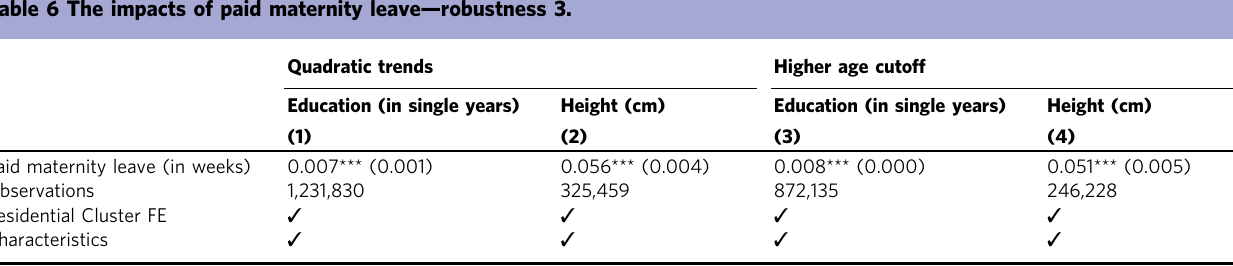
Table 6 The impacts of paid maternity leave — robustness 3.